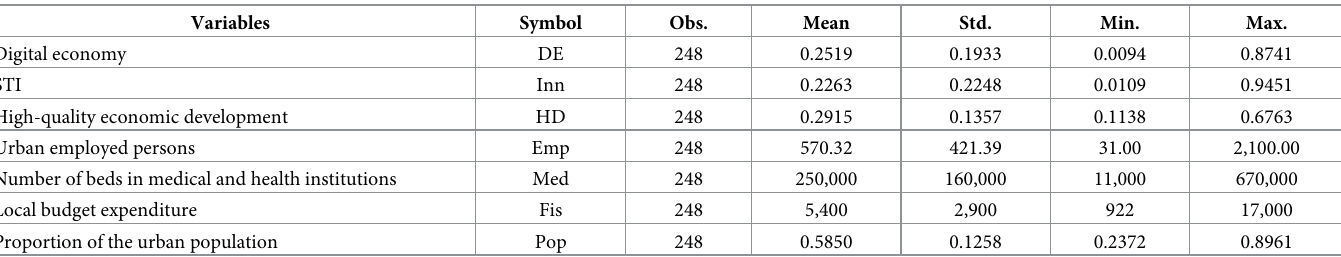
Table 5. Descriptive statistics of the sample data.